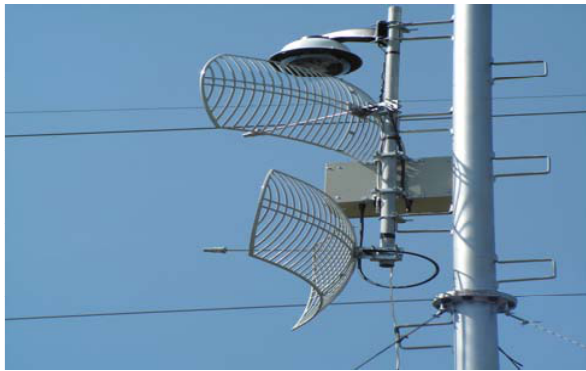
Figure 3. Multi-router traffic monitor of the network data on each link separately.